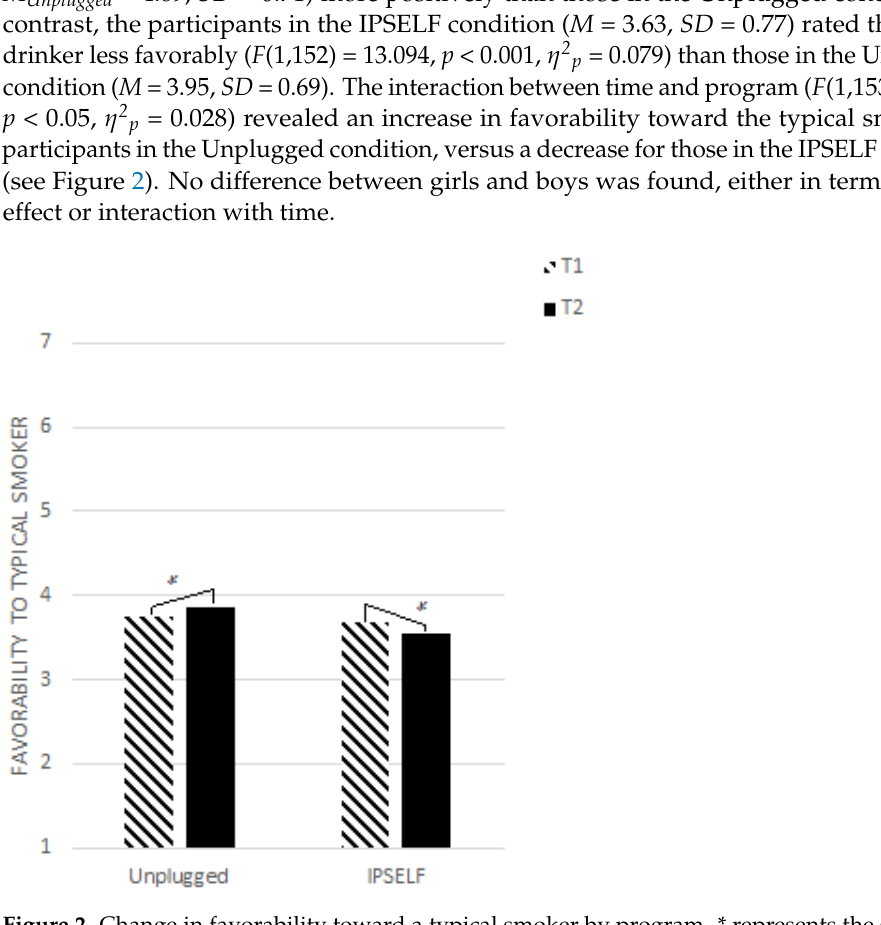
Figure 2. Change in favorability toward a typical smoker by program. * represents the significant effect